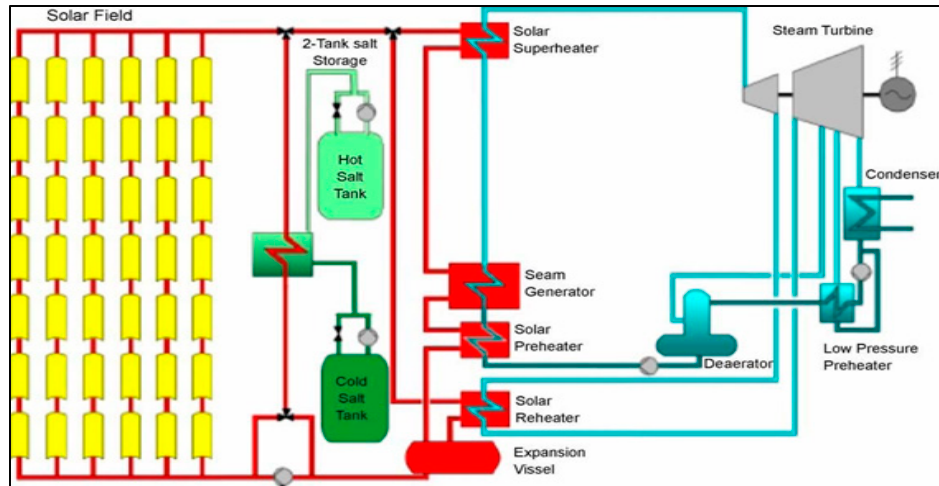
Figure 4. Schematic of a plant for generating electricity from solar energy using steam to drive a steam turbine with a solar heat source, Source: (Herrmann, 2002).